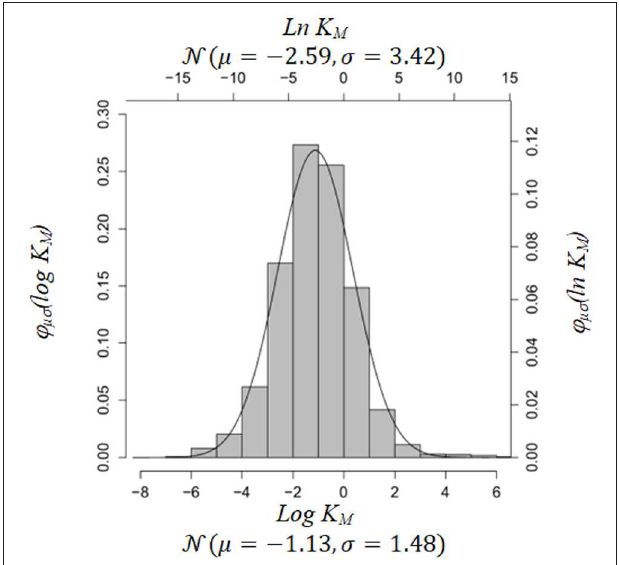
FIGURE 2 | Empirical distribution of all parameters in BioModels Database [19]. Source: